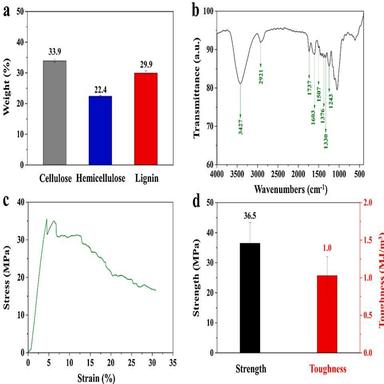
(a) The composition of cellulose, hemicelluloses, and lignin in bulk manau rattan, (b) FTIR spectrum of bulk rattan, (c) typical tensile stress-strain curve for bulk manau rattan, and (d) strength and toughness from the tensile stress-strain curve.